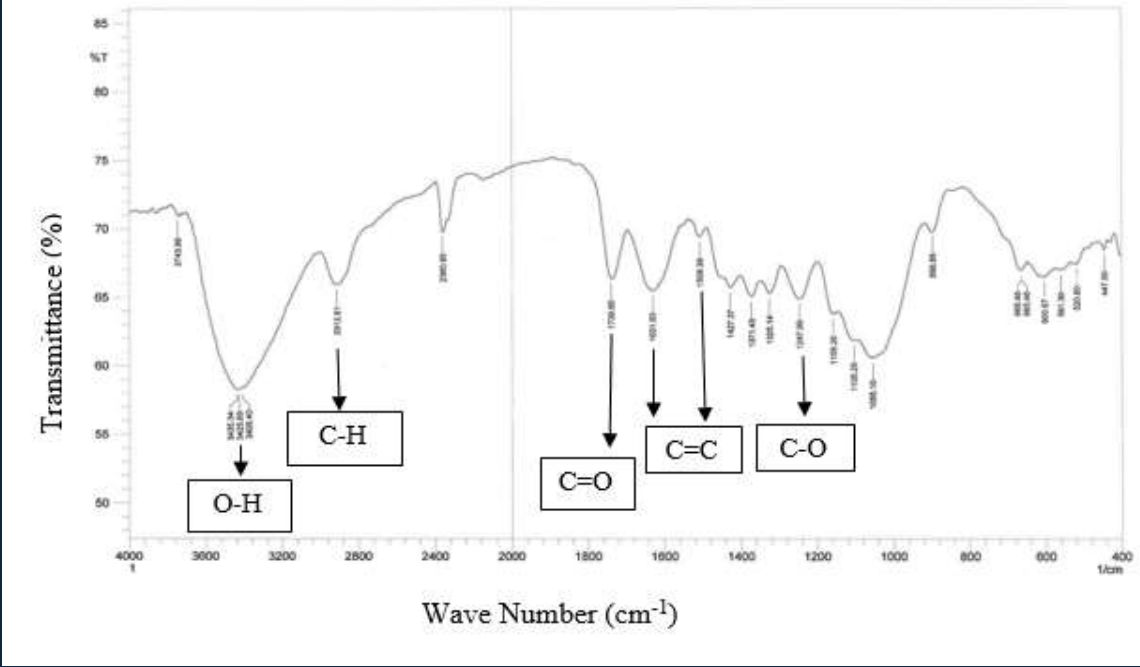
Figure 3: FTIR spectra of sisal fibers